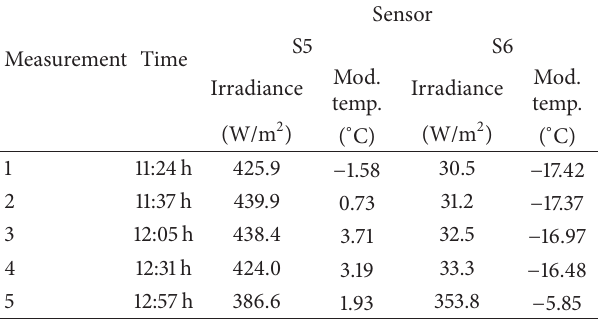
Table 5: Irradiances received by the PV string and module tem- peratures on December 4th, 2012, measured with sensors S5 and S6 located at both ends of String 4 at the moments when curves in Figure 15 were measured.